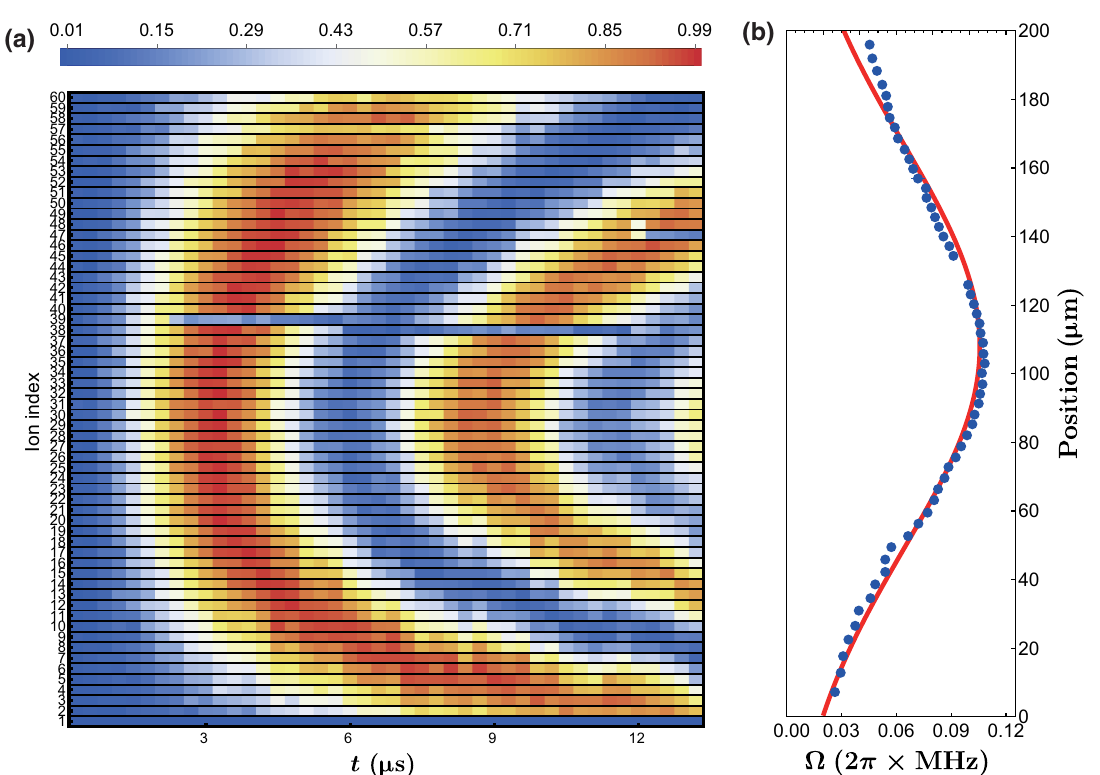
FIG. 5. Calibration of Rabi frequency. Here we set a total laser power of 800 mW for the two counterpropagating beams. The Rabi frequency under other laser intensities can be scaled accordingly. (a) Rabi oscillation of N = 60 ions. The missing data are due to two dark ions in the calibration process (likely being on the F 7 / 2 levels or becoming YbH + ). (b) The Rabi frequency is fitted by a Gaussian distribution with a full width at half maximum of approximately 144 μ